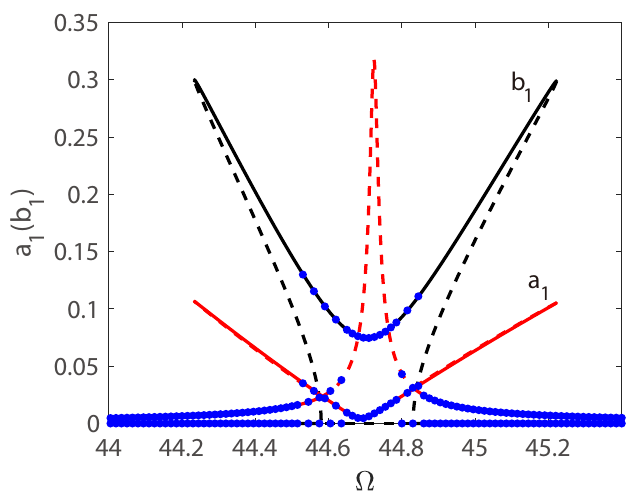
Figure 8. Amplitudes of response as functions of the detuning parameter δ . Line: pseudo-arclength continuation method, Points: long-time-integration method.